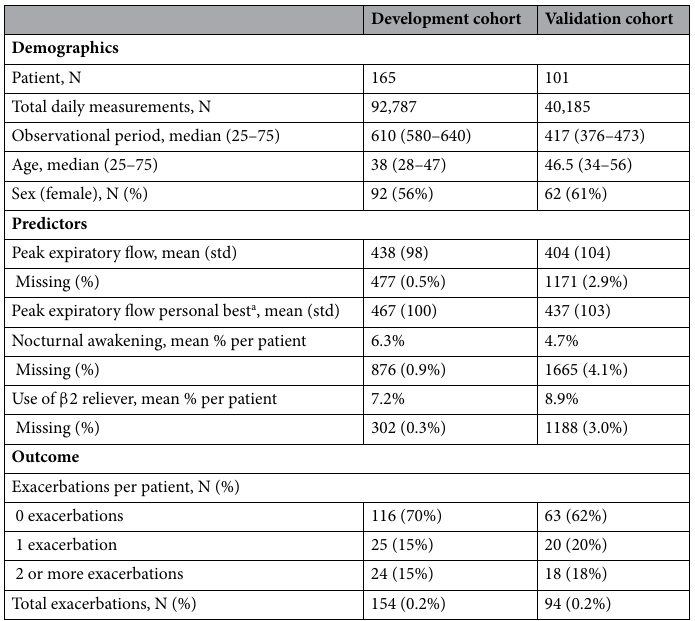
Table 1. Descriptive statistics of the development and validation cohorts. Statistics were calculated for each individual patient over their respective observational periods. Then these statistics were pooled across patients. a No % missing is reported for maximum peak expiratory flow as this is a summary statistic calculated per patient over a run-in period of 4